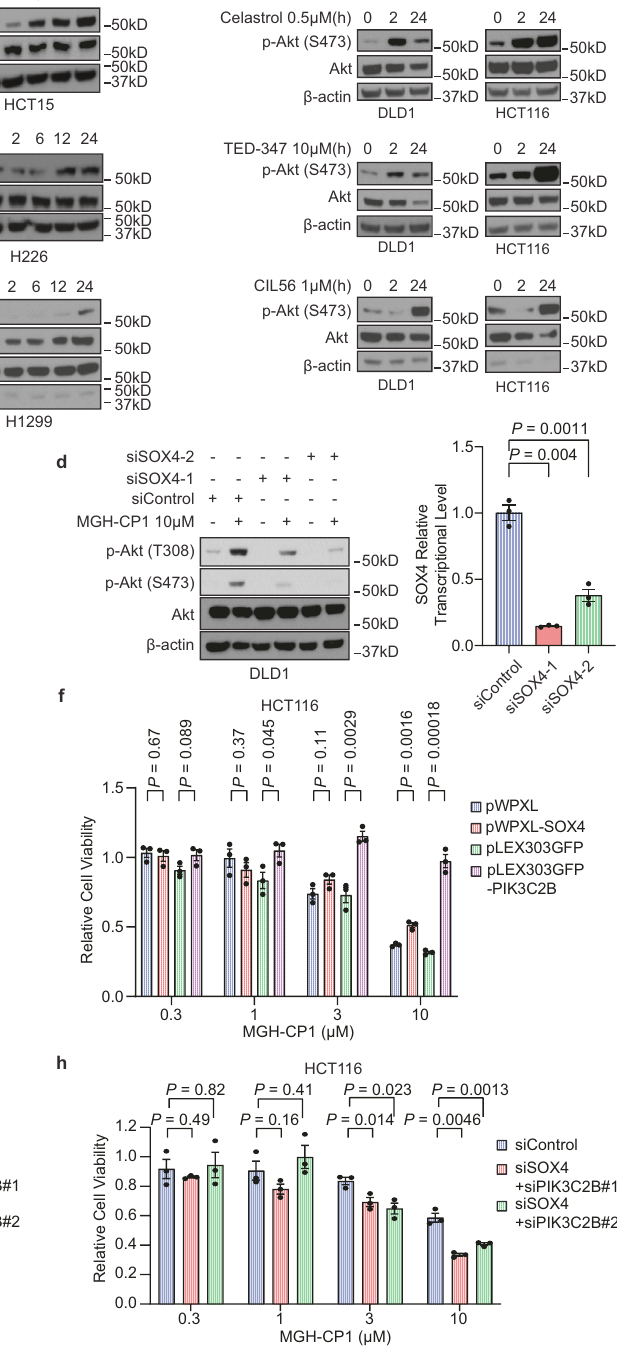
Fig.5|TEAD – YAPblockadeactivatesAKTactivitythroughPIK3C2BandSOX4. a Immunoblotofp-AKT(T308),p-AKT(S473)andtotalAKTinHuh7,DLD1,HCT116, HCT15, H226 and H1299 cells treated with MGH-CP1 at indicated time point. b Immunoblotofp-AKT(S473)andtotalAKTinDLD1andHCT116cellstreatedwith TEAD-YAP inhibitors, including celastrol, TEAD347 and CIL56 at indicated time point. c DLD1 and HCT116 cells were treated with either of MGH-CP1, pan-PI3K inhibitor Wortmannin, or combination. p-AKT (S473) and total AKT levels were determined by immunoblot. a – c Representative images were chosen from n =3 biologicalrepeats. d DLD1cellsweretransfectedwithsetsofSOX2siRNAs,followed